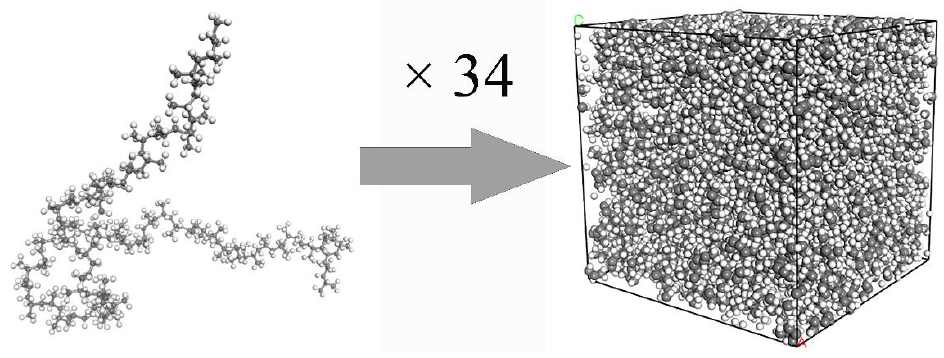
Figure 6. Formation of the PP